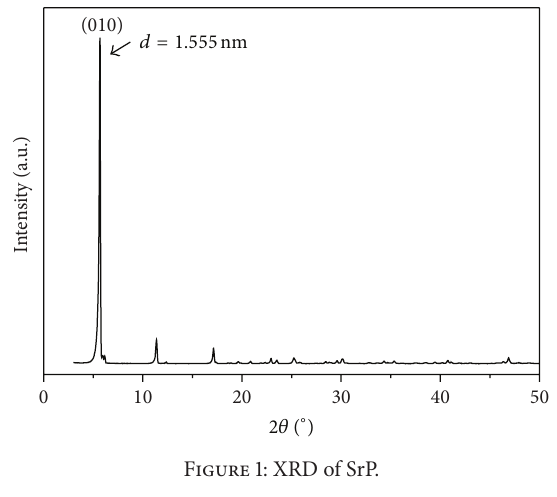
Figure 1: XRD of SrP.